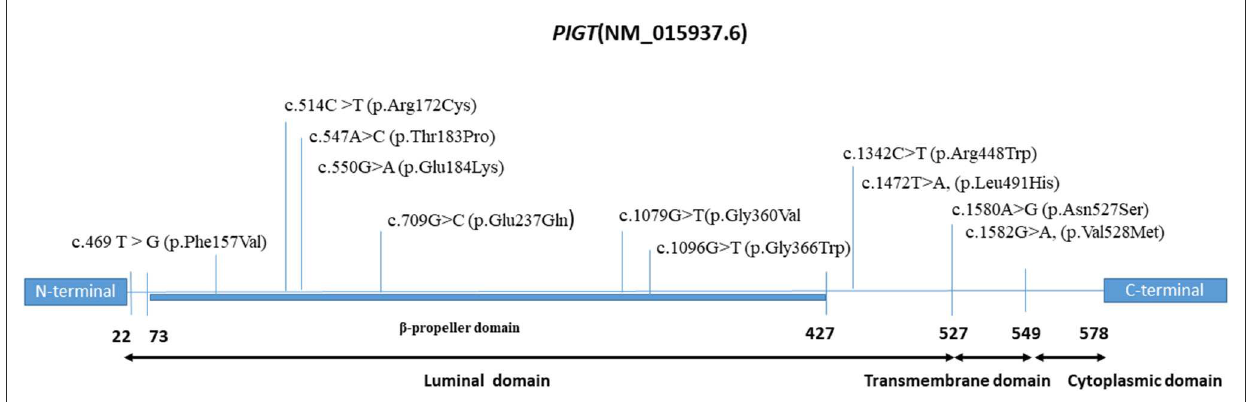
FIGURE3 Domain map of the PIGT protein depicting the locations of milder and severe pathogenic